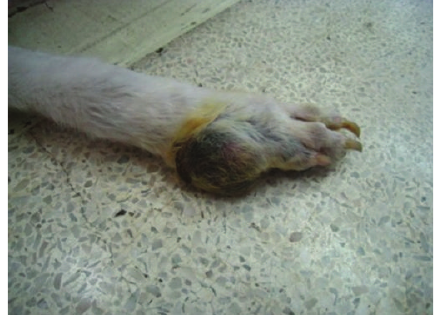
Figure 1: The location of MCT mass at the dorsomedial plane of the left palmar of the case in which the MCT cells were harvested from the site.